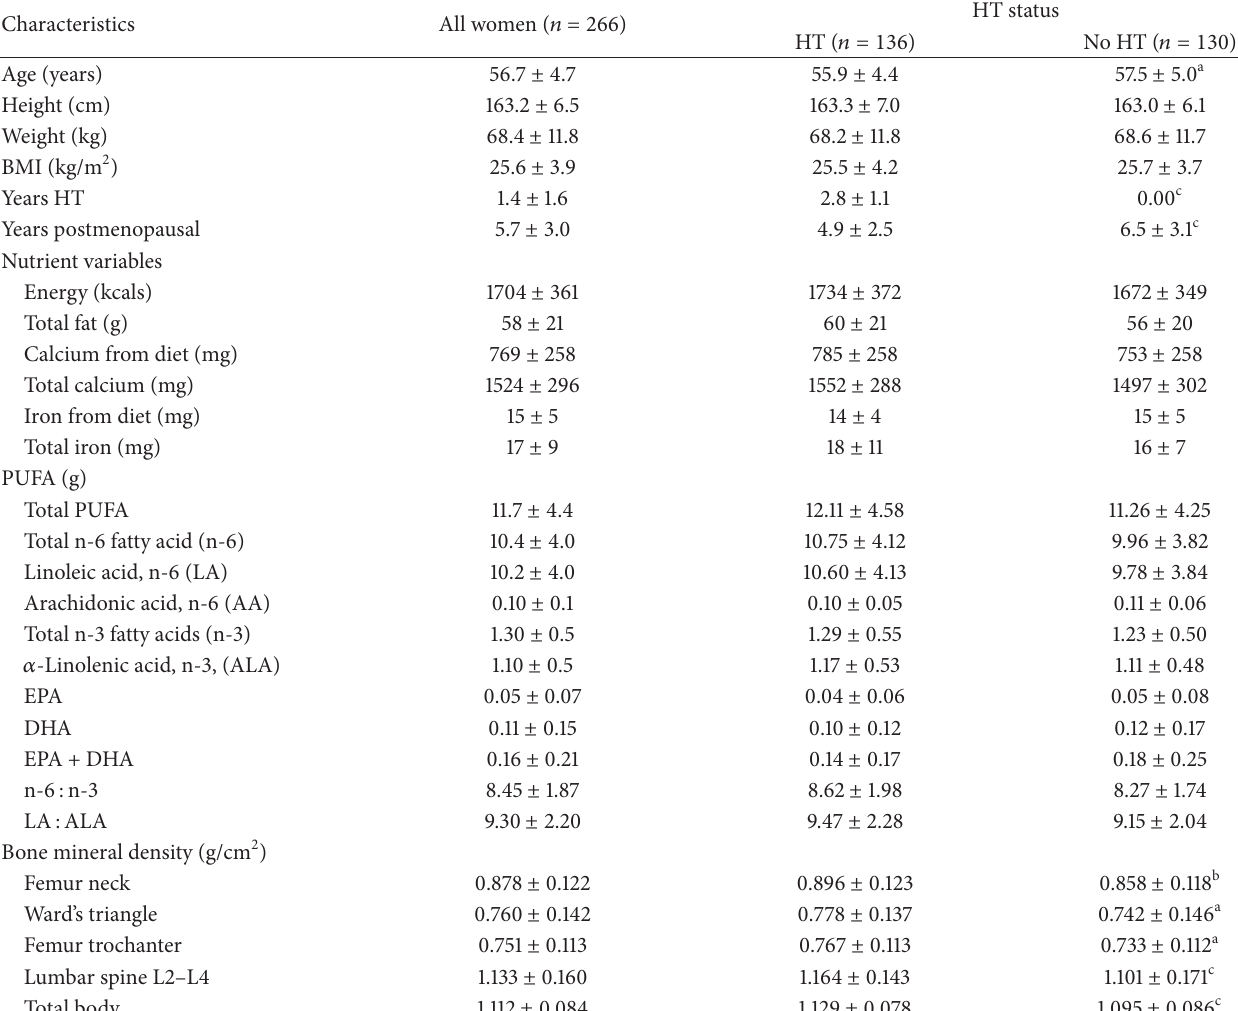
Table 1: One-year characteristics of 266 postmenopausal women using or not using hormone therapy (HT).